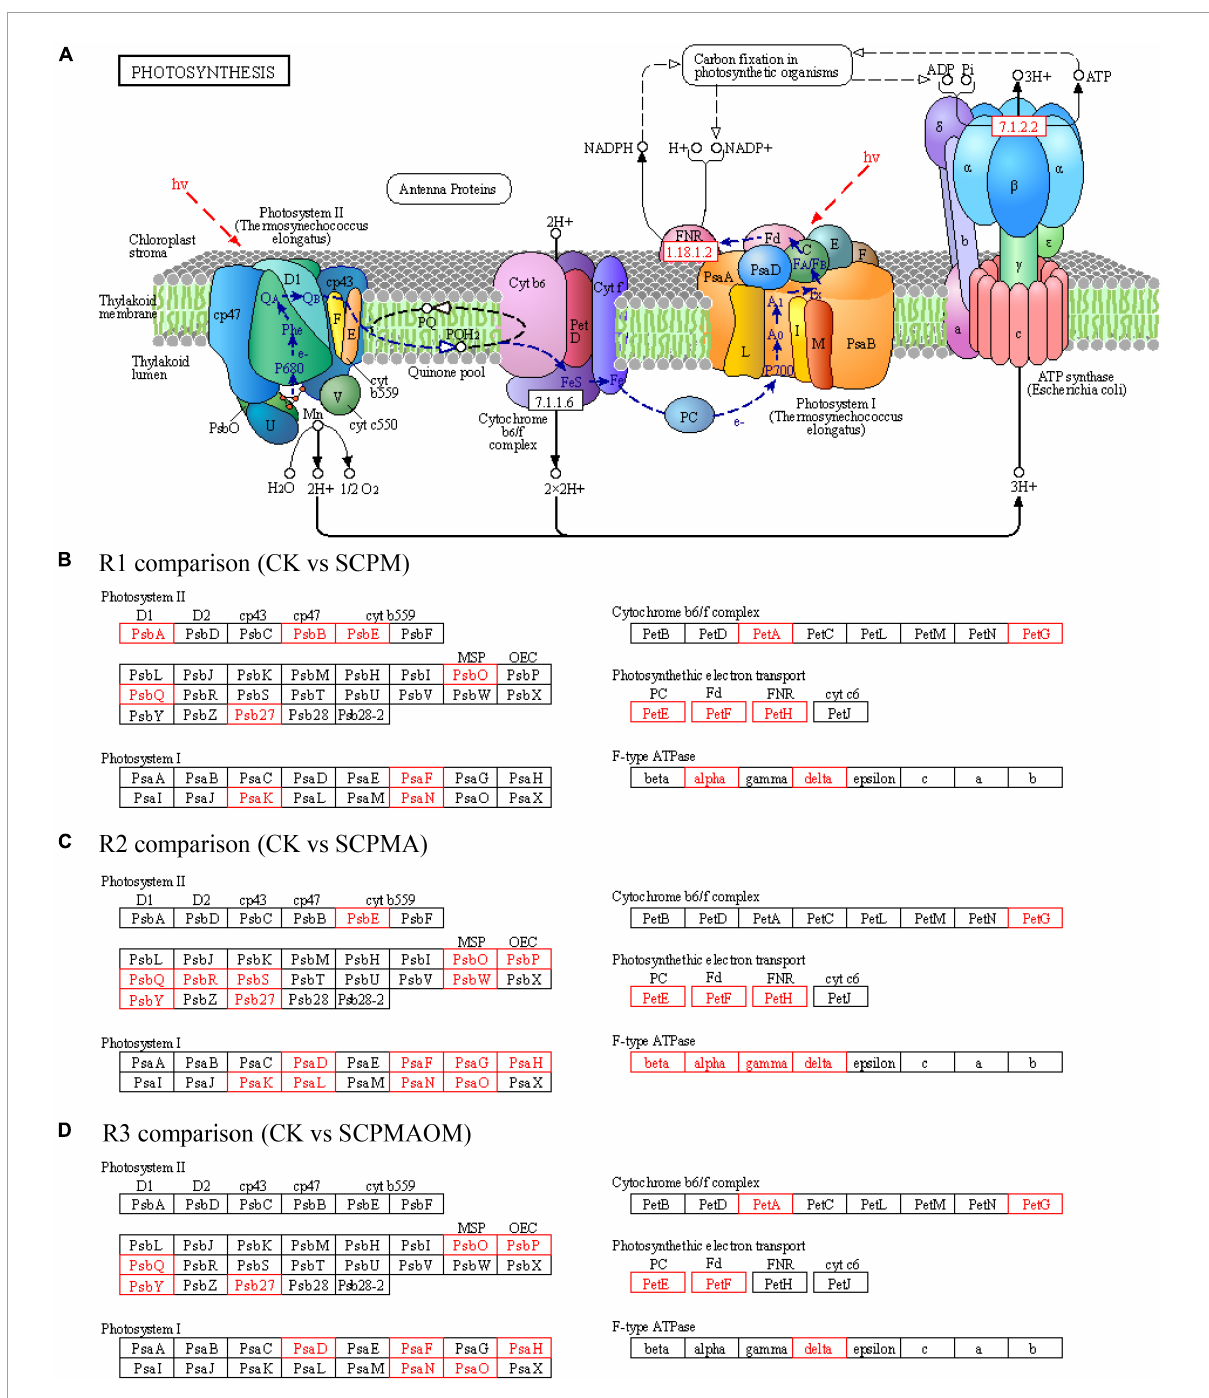
FIGURE4 Differentially expressed genes (DEGs) associated with photosynthesis pathway (A) in R1 (B) , R2 (C) , and R3 (D) comparisons. Red frames denoted up-regulated genes, while black frames denoted genes showing no differential expression. R1, CK vs. SCPM; R2, CK vs. SCPMA; R3, CK vs.